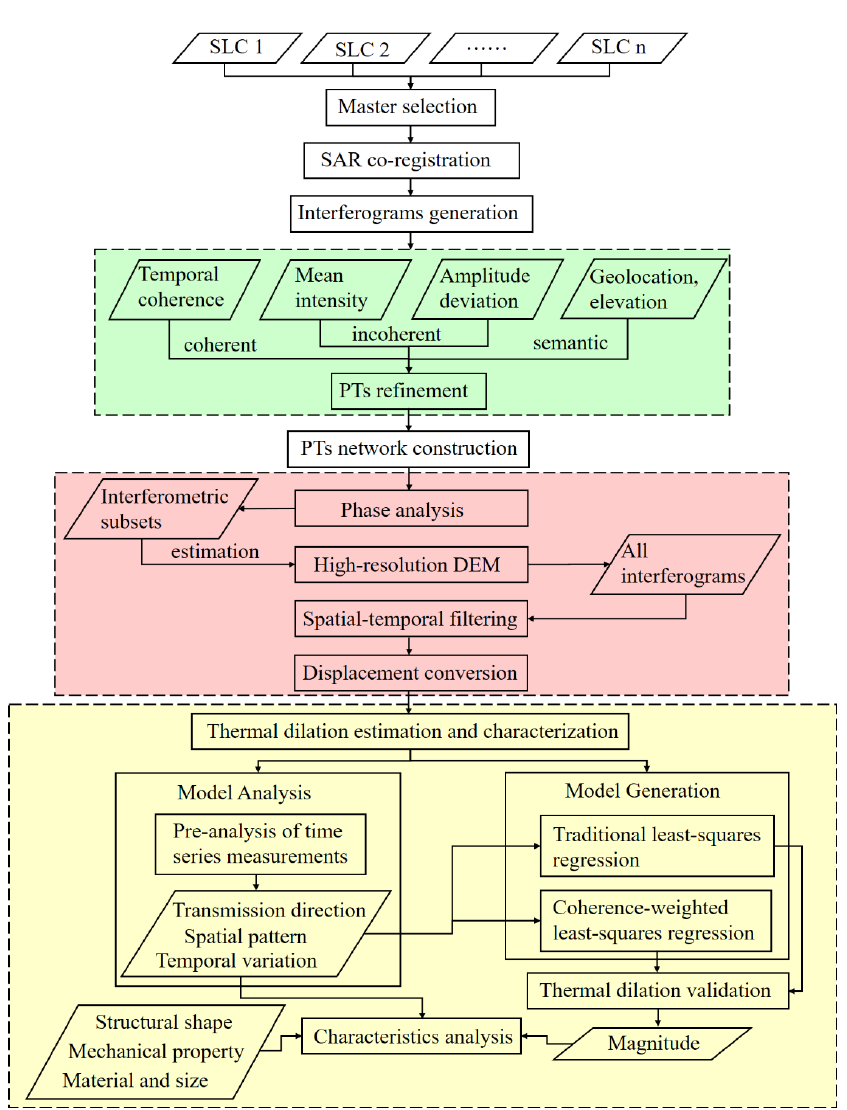
Figure 1. Main workflow of proposed multi ‐ temporal Differential Synthetic Aperture Radar Main workflow of proposed multi-temporal Differential Synthetic Aperture Radar Interferometry (DInSAR) approach. Interferometry (DInSAR)